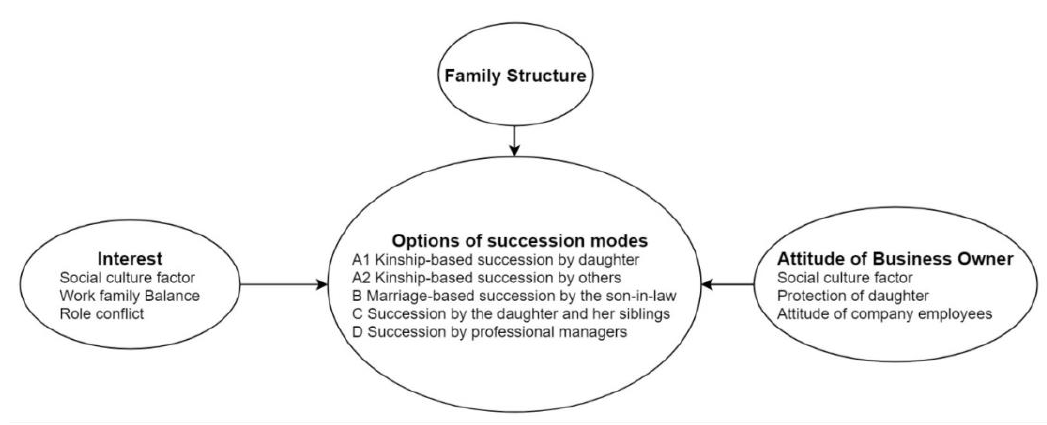
Figure 1: Influencing factors of succession